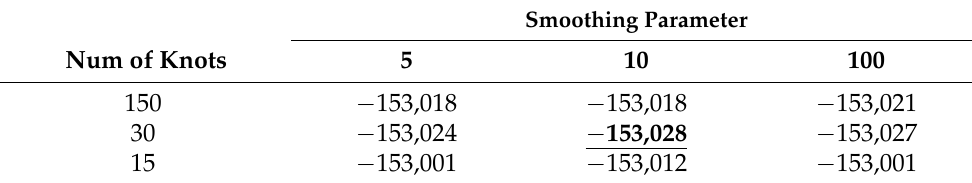
Smoothing Parameter